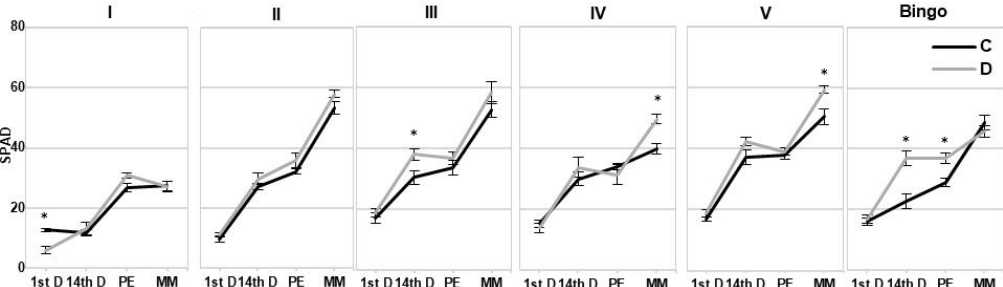
Figure 6. The chlorophyll concentration in SPAD units in the leaves of OMA lines and cv. Bingo on the 1st day of drought (1stD), 14th day of drought (14thD), panicle ejection phase (PE), kernel milk maturity phase (MM). C—control, 70% FWC, black line; D—drought, 25% FWC, grey line. The mean values (n = 5) ± SE marked with an asterisk (*) are significantly different at p ≤ 0.05 according to the Student’s t test.